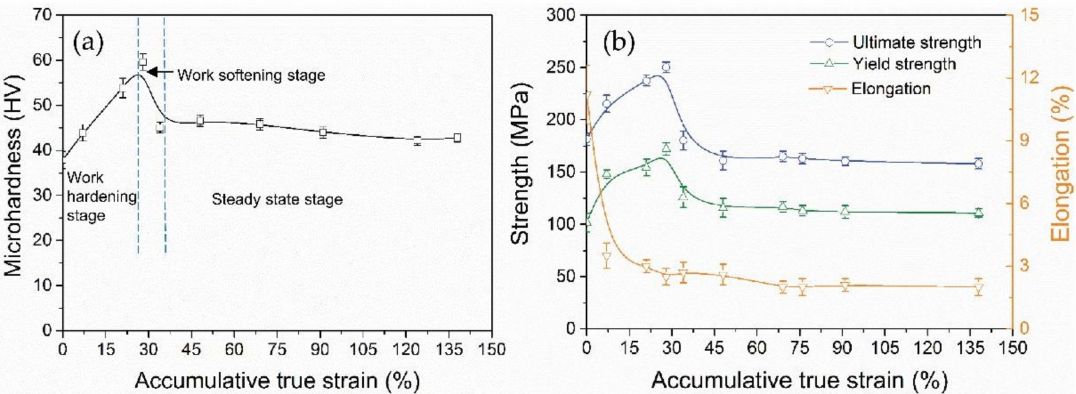
Figure 1. Mechanical properties curves of pure Mg wires, showing the effect of accumulative true strain (ATS) on ( a ) the microhardness, ( b ) the tensile strength and